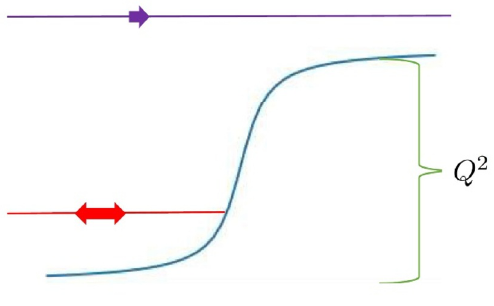
Figure 2 . The potential experienced by GR-like modes in tortoise coordinates: the potential is monotonic with a mass gap that scales like 1 =k . There are modes, marked in purple, that can escape to in(cid:12)nity, and modes, marked in red, that cannot. From the underlying SL(2 ; R ) point of view they are di(cid:11)erent: the red modes arise from the principal discrete representations and are accompanied by a non-perturbative partner in the BH interior. The purple modes arise from the principal continuous representations and are not accompanied by a non-perturbative